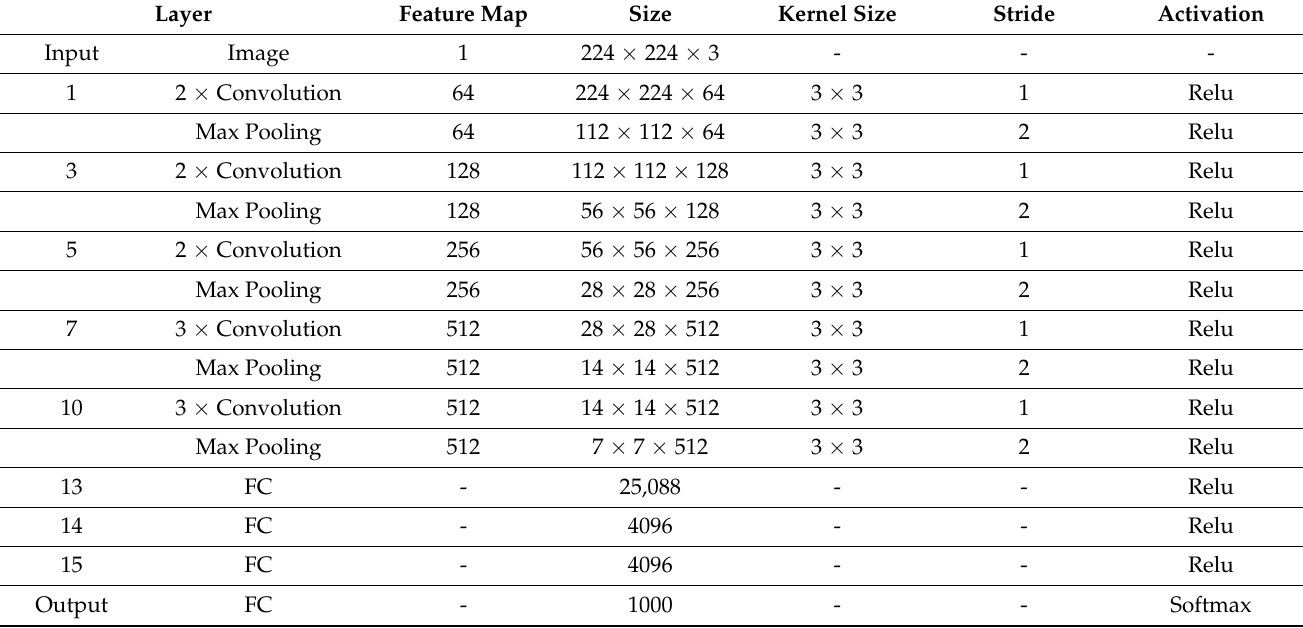
Table 3. Summary of VGG16 Architecture.